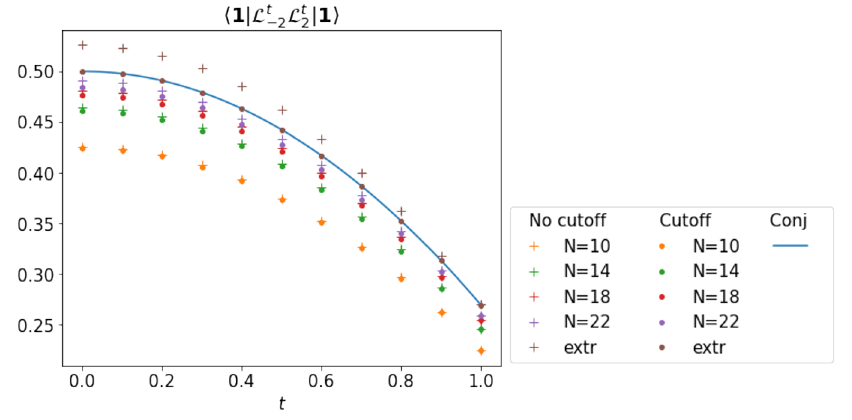
Figure 13 . Finite-size estimate for the central charge c as a function of interpolation parameter t at x = (cid:25) , using the same conventions as in (cid:12)gure 2. The generators L t